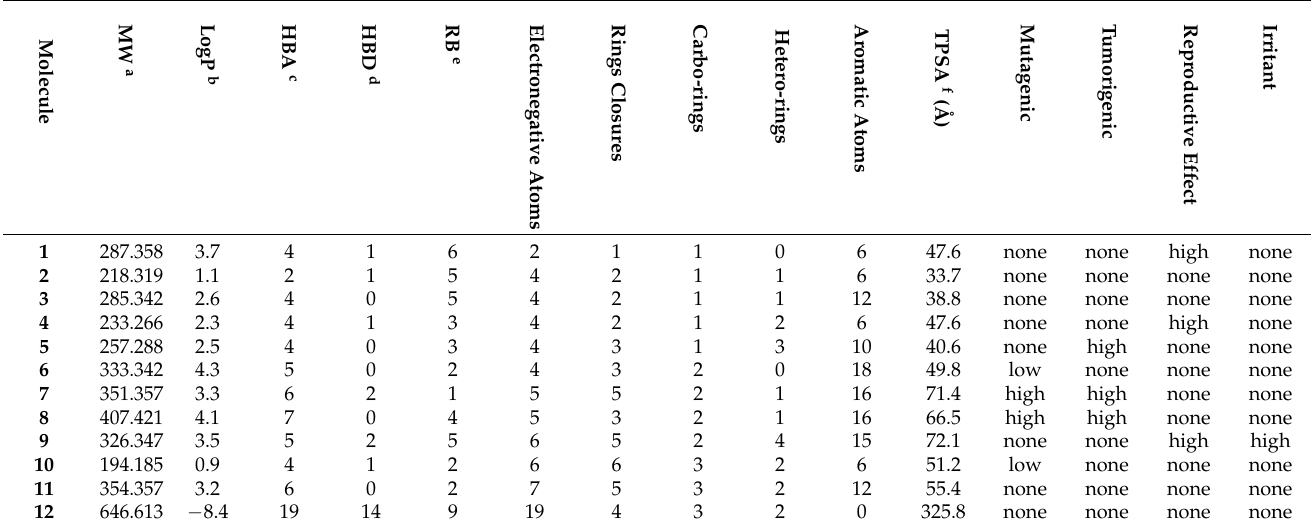
Table 2. Physicochemical properties of compounds 1 – 12